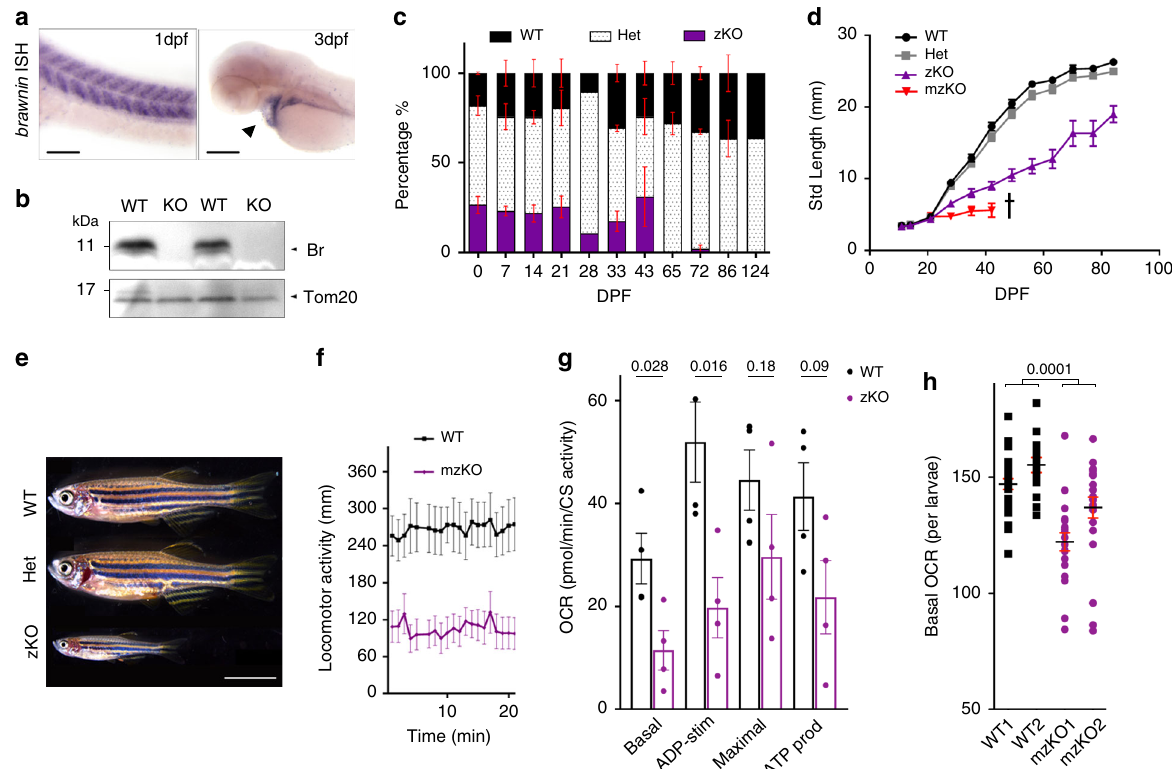
Fig. 4 Knockout of Br in zebra fi sh causes lethal mitochondrial de fi ciency. a In-situ hybridization (ISH) of brawnin (br) in zebra fi sh larvae. dpf = days post fertilization. Left panel: scale = 100 µ m, right panel: scale 200 µ m. b Western blot analysis of puri fi ed mitochondria from adult WT and KO (homozygous br Δ /br Δ ) skeletal muscle using zebra fi sh-speci fi c α -Br. c Mendelian percentages of offspring from heterozygous (Het) intercrosses genotyped at the indicated dpf. Data represent the mean of at least 2 clutches per time point (except 28 and 124 dpf) with at least 15 animals per clutch. Error bars indicate SEM. d Standard length (mm) measurements of WT, Het, and zygotic KO (zKO) larvae generated from an F 2 intercross genotyped and segregated at 3 dpf. Maternal zygotic KOs (mzKOs) were generated from a homozygous incross and measured until 42 dpf when all animals succumbed to disease. Data are representative of four independent experiments from two independent Cas9/gRNA injected br Δ KO allele founders. Number of animals at the beginning of the experiment: WT = 14; HET = 37; zKO = 8; mzKO = 22. Error bars indicate SEM. e Representative images of WT, Het, and zKO clutch-mates at 65 dpf. Scale = 5 mM. f Basal motility monitoring continuous swim tracking of WT and mzKO larvae at 11 dpf. 23 animals per genotype monitored. Error bars indicate SEM. g Coupled respiratory analysis of isolated SKM mitochondria measured on Agilent Seahorse in the presence of succinate + rotenone, read out as CS-normalized OCR. Basal, ADP stimulated, maximal respiration and ATP production were plotted. Data represent mean and SEM of four biological replicates. p -values from two-sided paired t -test. h Basal respiratory rate of free moving 1 dpf WT and mzKO larvae measured on Agilent Seahorse platform. Number of animals: WT1 = 30; WT2 = 15; KO1 = 21; KO2 = 23. Data represent mean and SEM, p -values from two-sided unpaired t